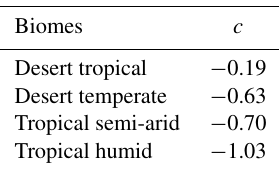
Table A5. Parameter values of the CO 2 function in Sallaba et al. (2015) Eq. (5)